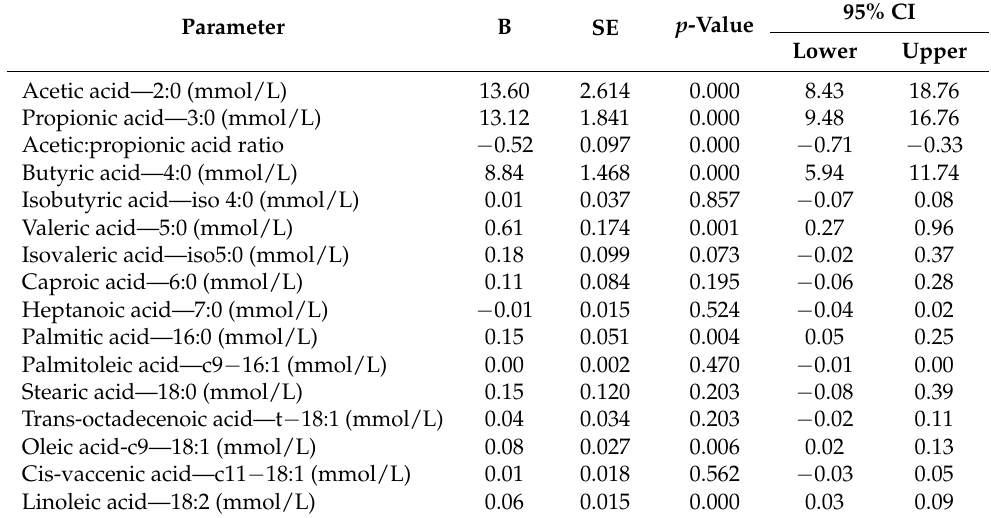
Table 1. Association between ruminal pH status [low ( ≤ 5.5) and normal values (>5.5)] and ruminal fatty acids